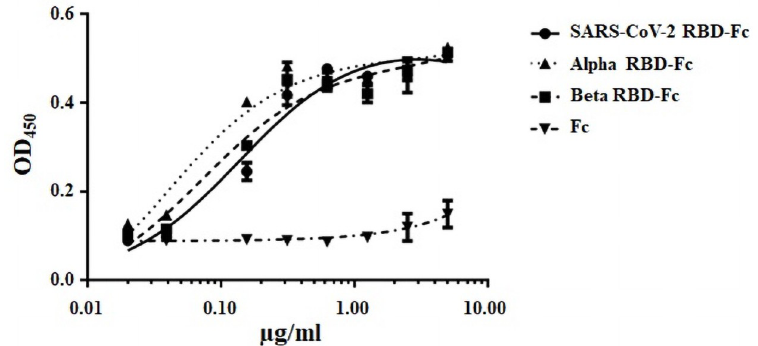
Fig 4. In vitro binding of purified plant-produced SARS-CoV-2 RBD-Fc and variants to human ACE2. The binding affinity to ACE2 was determined by ELISA. Two-fold dilution of plant-produced SARS-CoV-2 RBD-Fc, Alpha RBD-Fc, Beta RBD-Fc, and Fc proteins were incubated on plates coated with human ACE2 protein. The bound protein was detected with HRP-conjugated goat anti-human IgG. The data are the mean ± SD of triplicates assay from each